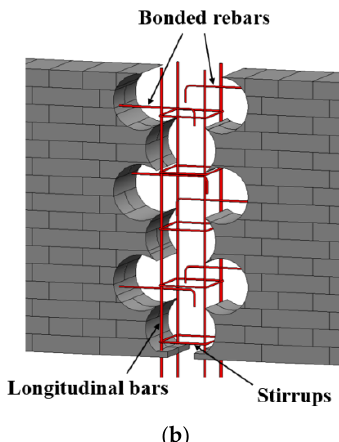
Figure 2. Construction details: ( a ) horizontal connection between the DBWSs; ( b ) the reinforcement configuration at vertical joints details.